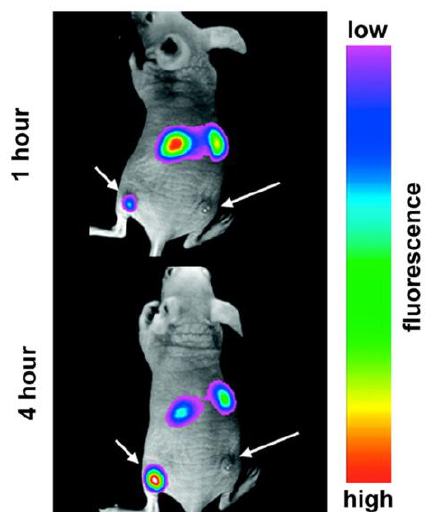
Figure 9. Fluorescence contrast of tumor growth when the mouse is injected with upconversion nanoparticles. Reproduced with permission from Ref. [115].